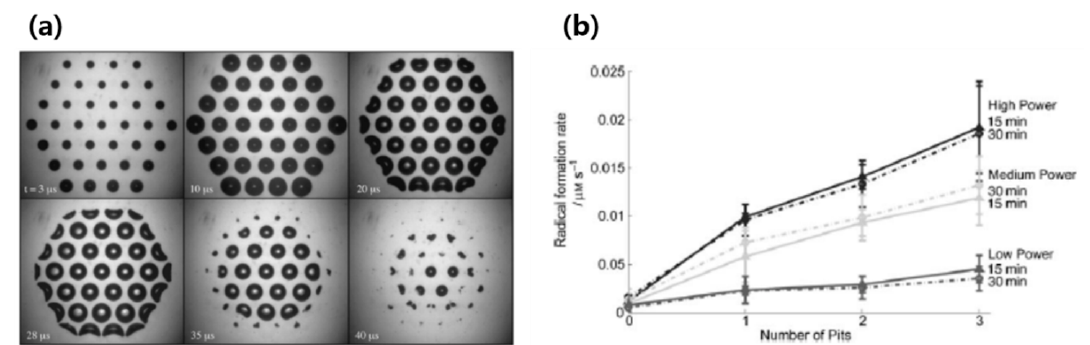
Figure 8. ( a ) Time sequence displaying the nucleation and collapse of bubbles from the hydrophobic hexagonal patterned surface and ( b ) cavitation effects with respect to the number of nucleation sites (radical formation rate shown on the y-axis is proportional to cavitation effects). Reprinted with permission from reference [59], copyright 2006, Elsevier and from reference [60], copyright 2010, John Wiley and Sons.